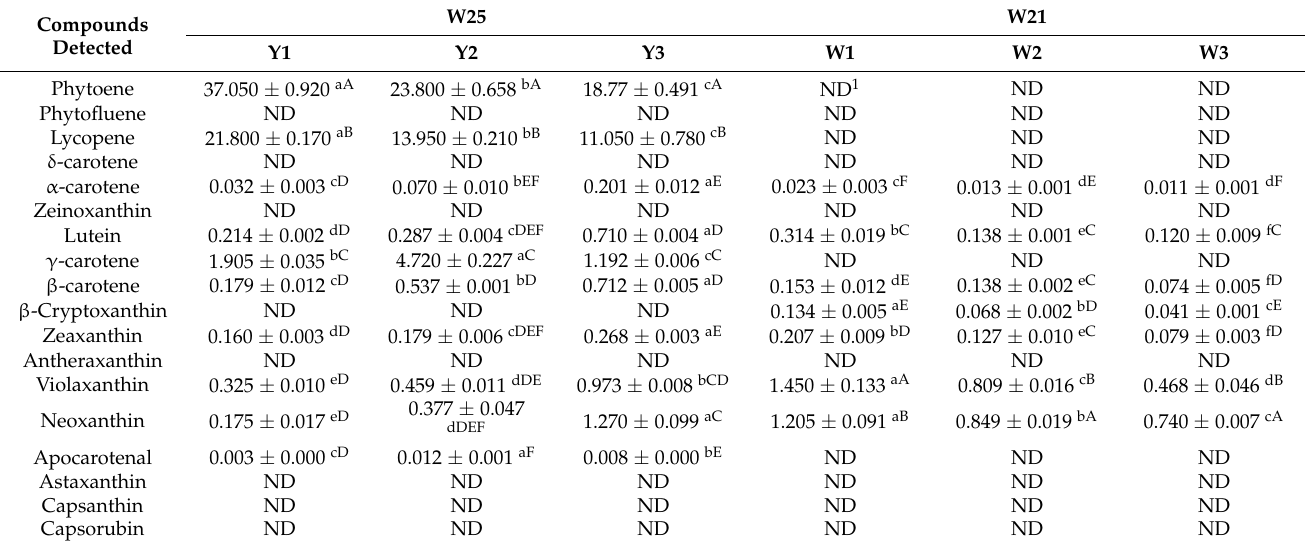
Table 1. All detected carotenoid components and their contents (mg/100g DW) in two turnips ( B. rapa ssp. rapa